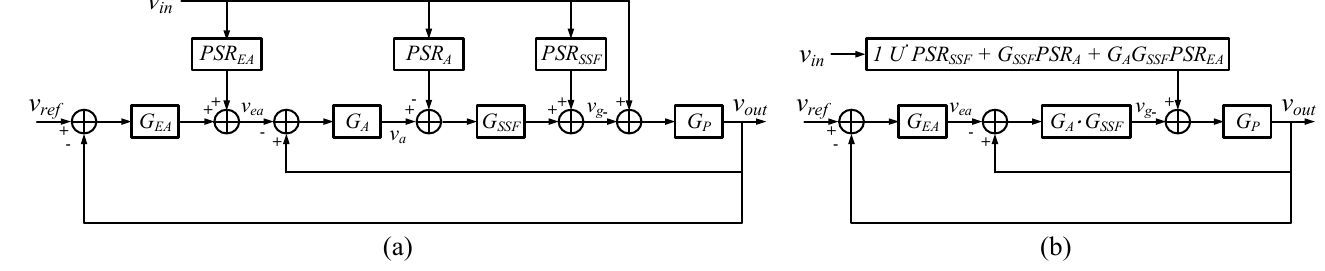
Figure 6. ( a ) Small-signal block diagram of the FVF LDO and ( b ) its simplified model.